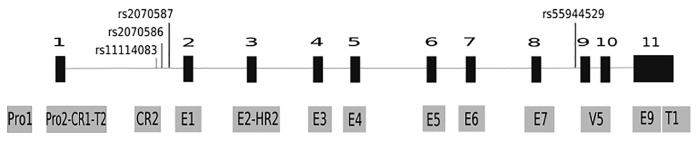
The sequenced regions of DAO in this study.DAO genetic sequencing regions (gray box) are displayed throughout the promoter (pro), and 11 exons (E) (black box). These sequenced regions include the transcripts (T) and variants (V) of expressed sequence tags, the highly conserved region (CR) and the previously significant disease-associated haplotype region (HR). The primer pairs for all sequencing regions are presented in Table A in S2 File. The SNPs of rs11114083, rs2070586, rs2070587, and rs55944529 genotyped in this study are indicated within the genetic region.